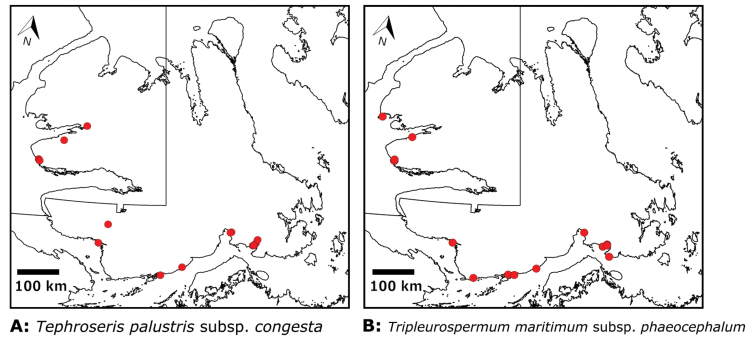
Species distribution maps. Asteraceae: ATephroseris
palustris
subsp.
congestaBTripleurospermum
maritimum
subsp.
phaeocephalum.